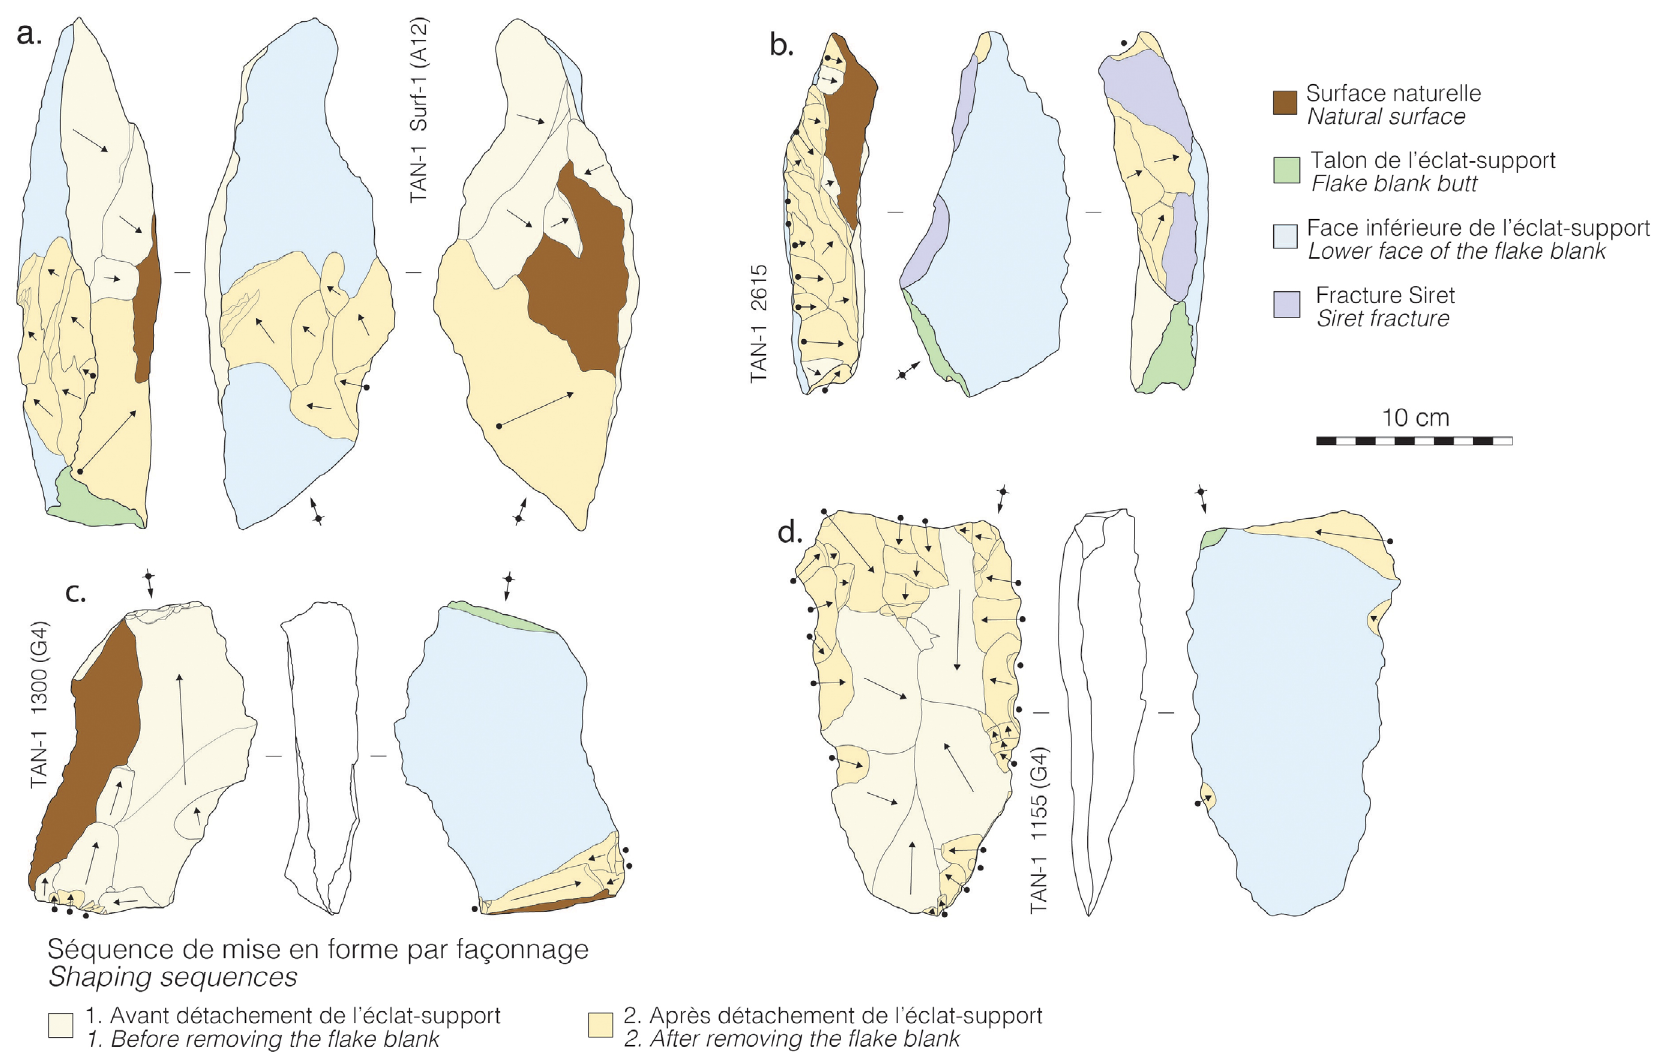
Figure 13. Schéma diacritique des ébauches sur éclat de Tanataetea. Figure 13. Diacritical sketch of Tanataetea flake blank Journal of Lithic Studies (2017) vol. 4, nr. 2, p. xx-xx doi:10.2218/jls.v4i2.2546